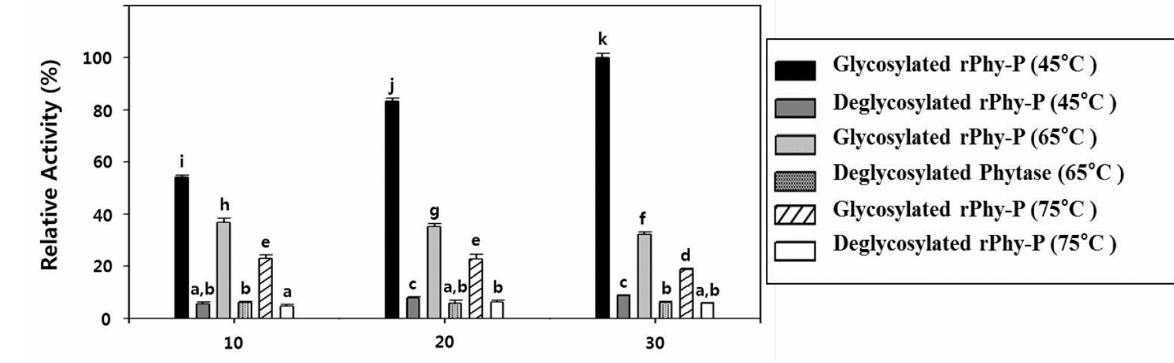
Figure 6. Glycosylation effect on the thermostability of the phytase activity of rPhy-P was assayed after incubation at 45, 65 and 75 °C for 10–30 min. Data are expressed as the phytase or relative activity, and each value represents the mean ± SE ( n = 6). Different letters indicate significant differences ( p <